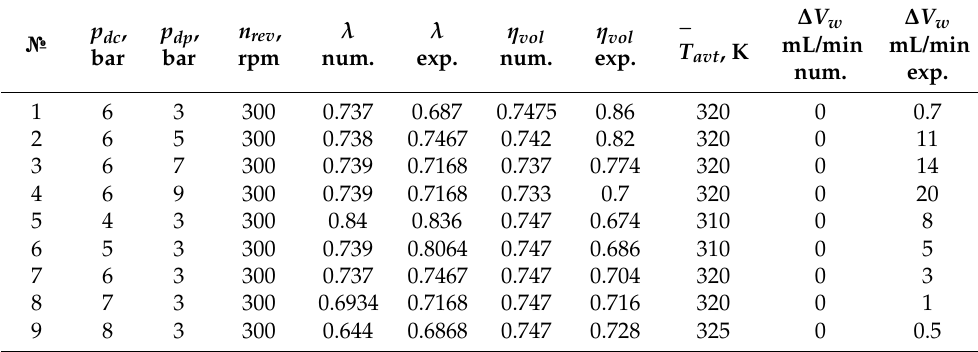
Table 2. The results of numerical and experimental studies of crosshead-free